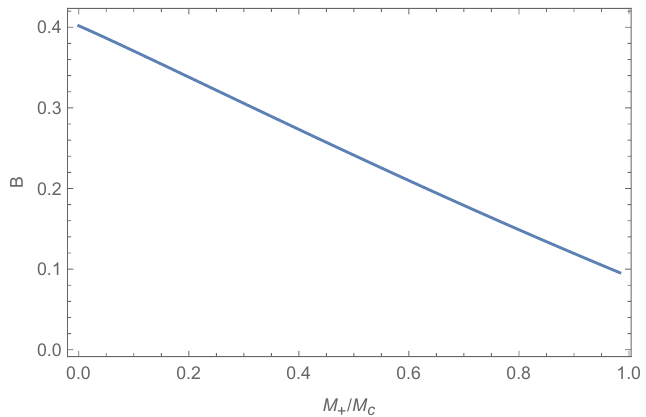
Figure 4 . The tunneling coefficient B of the bubble nucleation in SAdS black hole as the function of M + /M c . In this plot, G = 1 , L + = 1 . 4 , L − = 1 , σ = 1